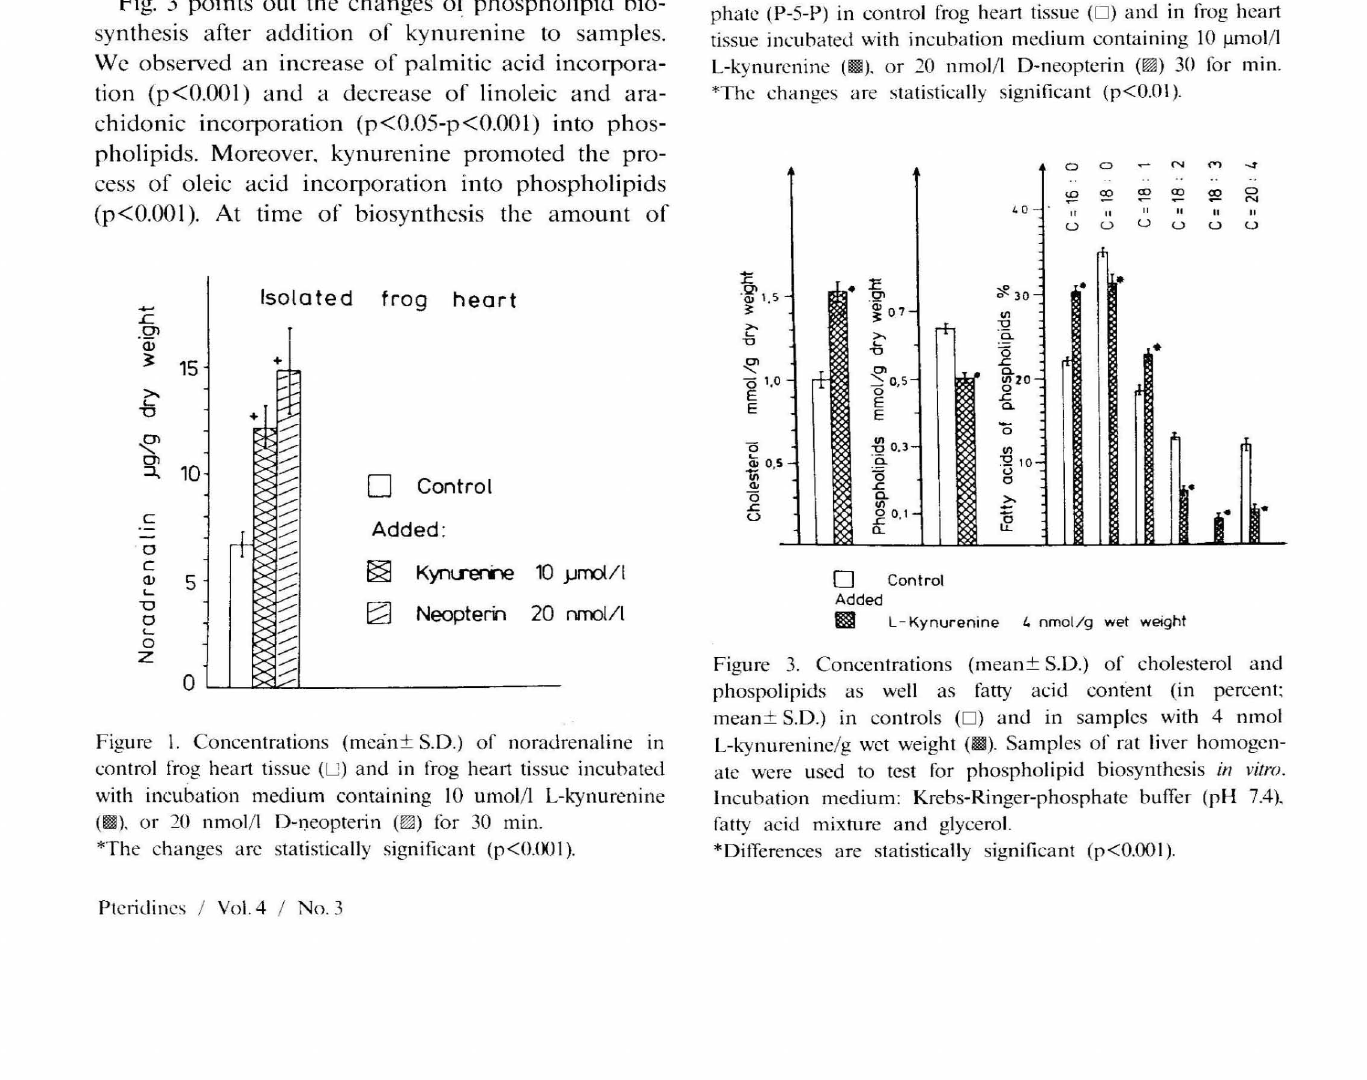
Fig. 3 points out the changes of phospholipid bio synthesis after addition of kynurenine to samples.